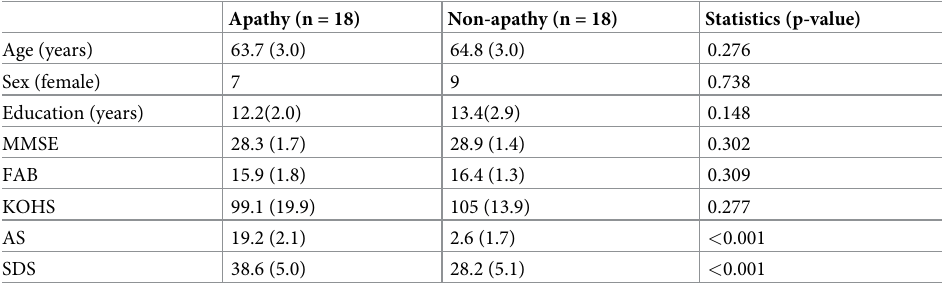
Table 1. Demographic and clinical characteristics of the apathy and non-apathy